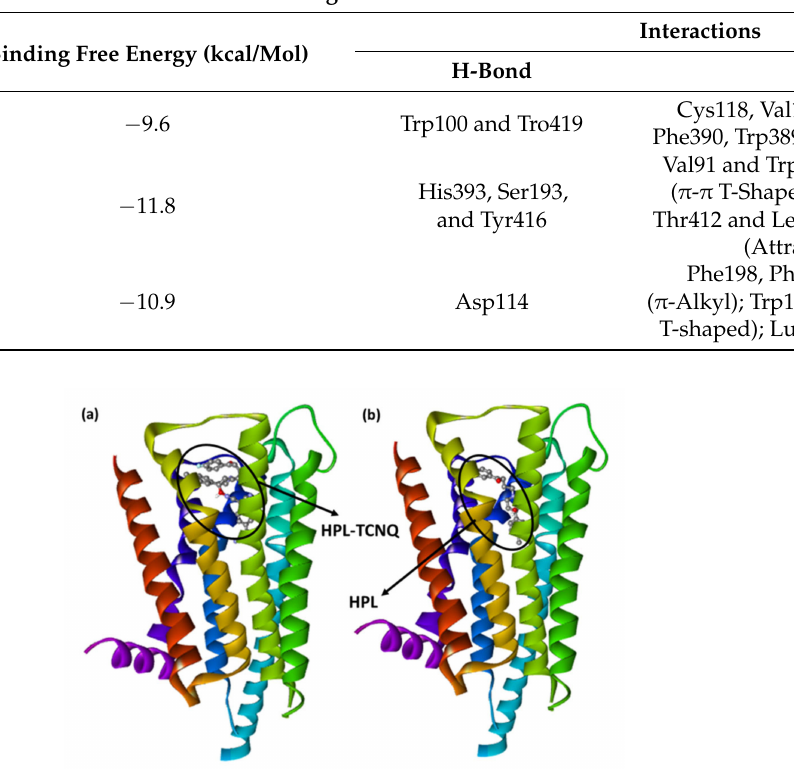
Figure 4. The best-docked position showing a helical model of dopamine docked with ( a ) CT complex and ( b ) HPL drug